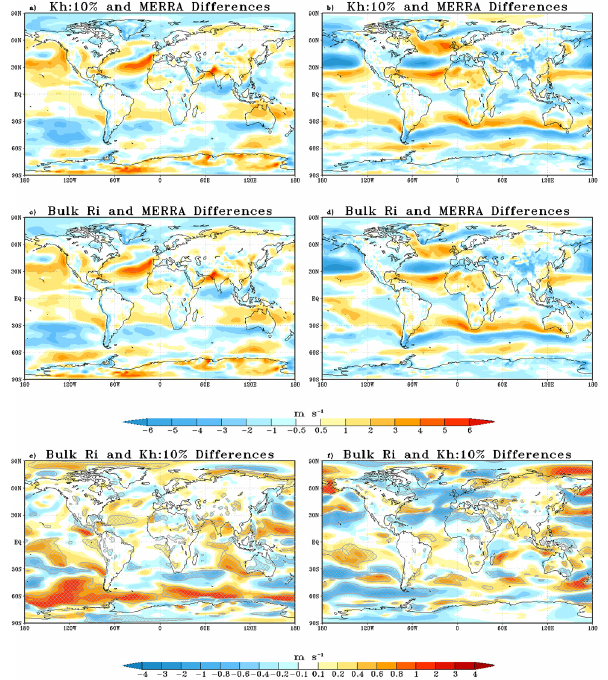
Figure 8. Seasonal mean 10m wind speed differences. Method 2 minus MERRA for JJA (a) and DJF (b) , Method 3 minus MERRA for JJA (c) and DJF (d) , and Method 3 minus Method 2 for JJA (e) and DJF (f) . Hatch marks on the bottom plots represent significance at the 90% level using the Student’s t test. Crosshatch marks repre- sent significance at the 95% level.